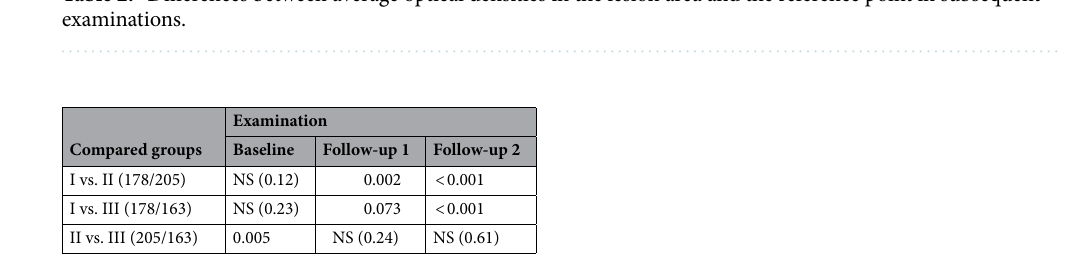
Table 3. Significance levels of optical density differences in compared groups in subsequent examinations.